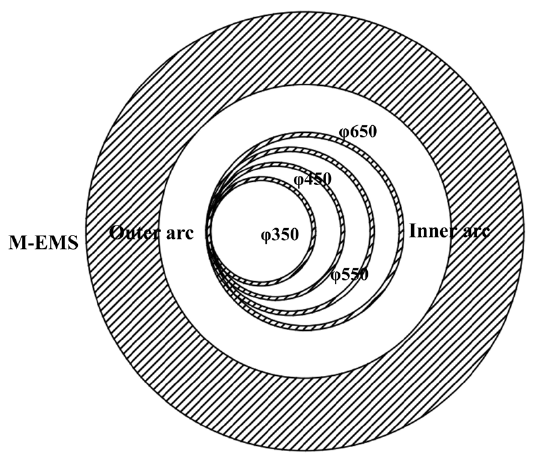
Figure 12. Position of mold copper tube relative to M-EMS for each section size of round blooms.